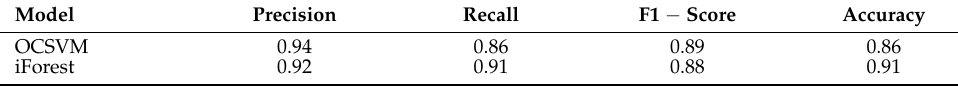
Table 5. Results of the anomaly detection methods.